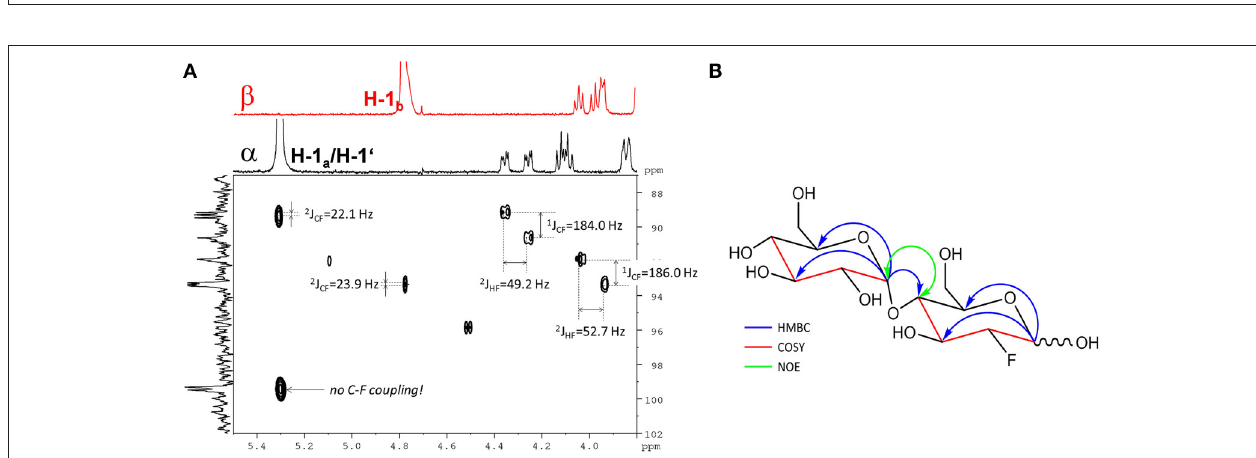
FIGURE 4 | Assignment of the fluorinated disaccharide. (A) Detail of the 1 H- 13 C HSQC spectrum from the fraction containing the fluorinated disaccharide m/z 343.1051. Characteristic C-F and H-F couplings are given. Two different shifts ( δ c 99.3/99.5) for C-1 ′ appear depending from the configuration of the FDG part. The F2-Projection shows the selective TOCSY spectra for the α / β -FDG part. (B) Key correlations used for the structure elucidation of the fluorinated disaccharide m/z 343.1051. Blue arrows indicate 1 H- 13 C HMBC correlations from the position 1 of the respective sugar units. The red parts of the structure indicate for neighboring positions probed by selective COSY experiments. The green double tipped arrow shows the NOE evidence for the α (14) junction between the two sugar